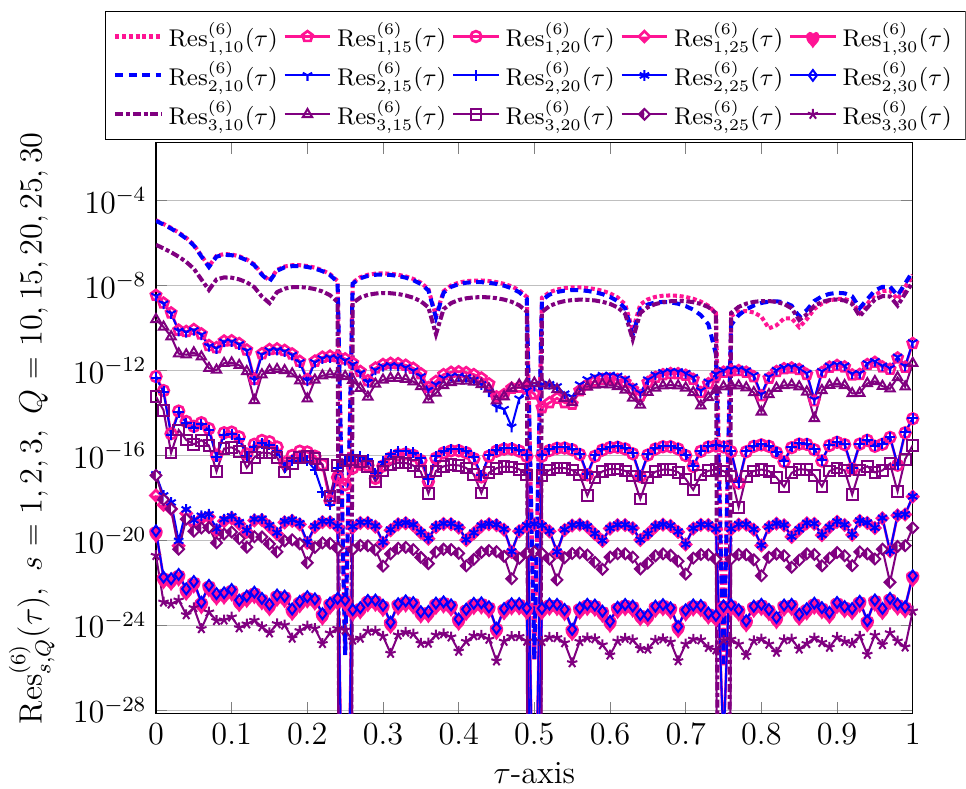
Figure 5. Comparisons of achieved REFs via QLM-SMV in Test Case 2 with Q = 10,15,20,25,30.